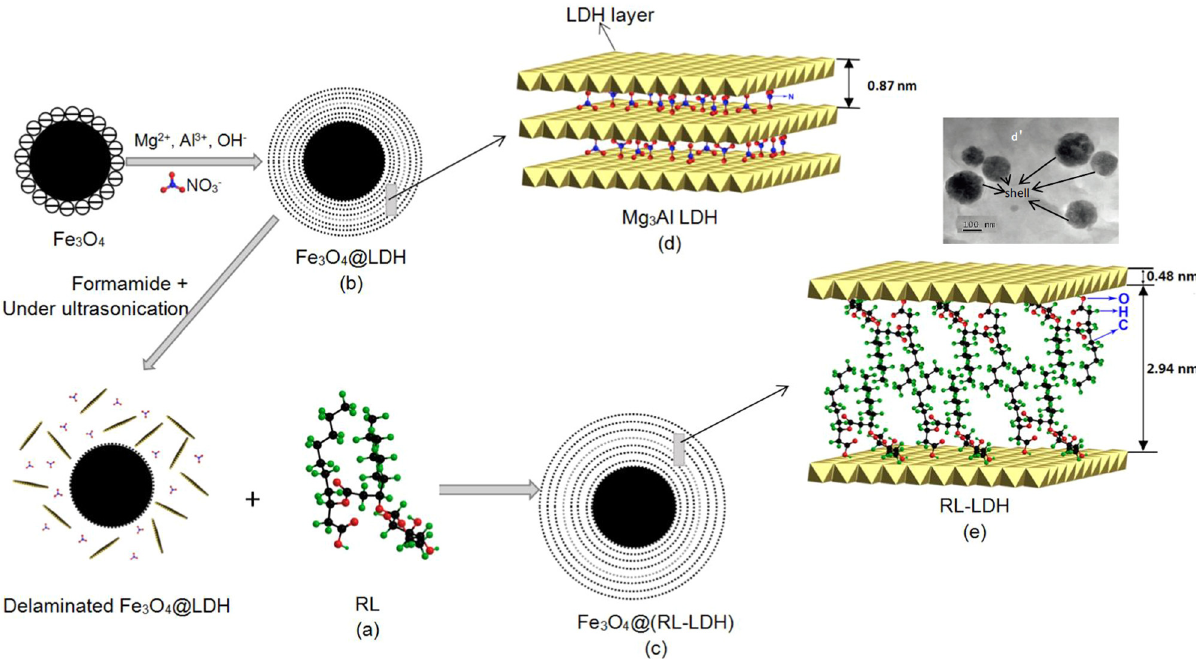
Figure 8: Schematic illustration of preparation Fe 3 O 4 /MgAl – LDH – RL [ 111 ]